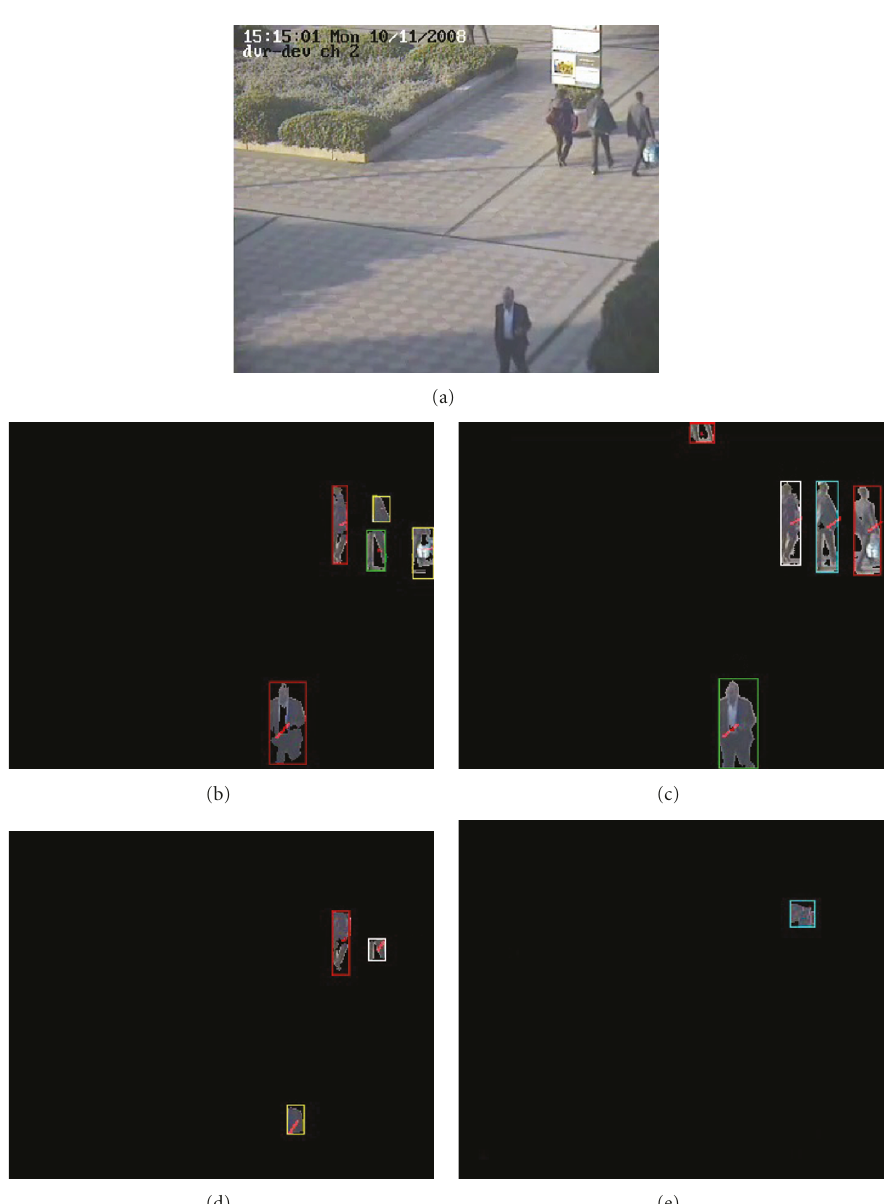
Figure 4: Examples of the output of the foreground detection on the MIVIA3 dataset; (a) Original Image; (b) EBS Algorithm; (c) MOG Algorithm; (d) SOBS Algorithm; (e) SBA